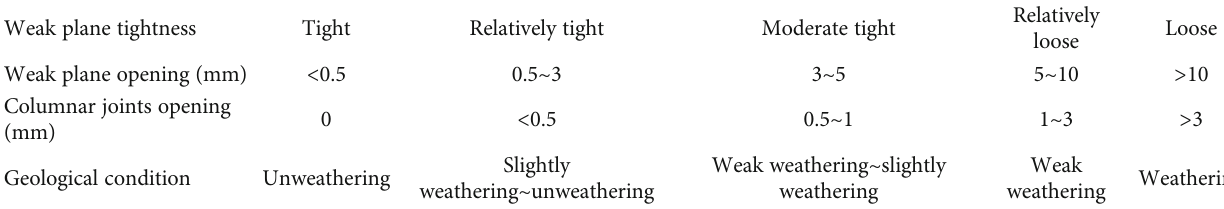
Table 5: Weak plane tightness classi fi cation.